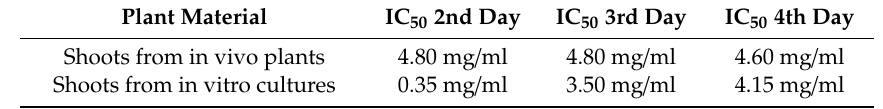
Table 5. Determination of IC 50 [mg / mL] for the studied extracts of Eryngium alpinum L.